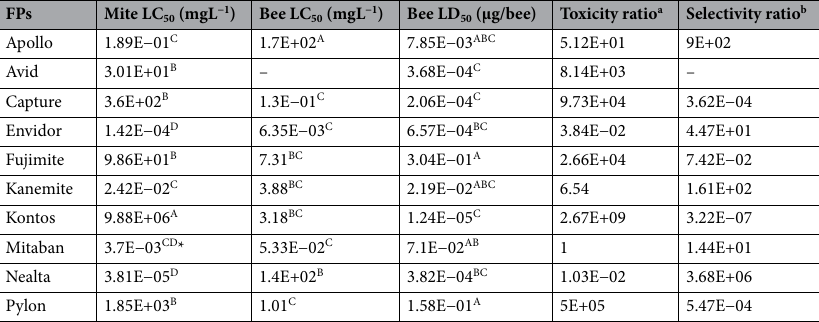
Table 3. Lethal concentration fifty (LC 50 ) and dose fifty (LD 50 ) values for 24 h responses of V. destructor and A. mellifera to tested FPs (n = 10). Mitaban was evaluated as reference control. Values with overlapping CIs in each column are not considered significantly different as indicated with the same letter ( p > 0.05). a Toxicity ratio was calculated by dividing the LC 50 for each AI by LC 50 for Mitaban. b Selectivity ratio was calculated by dividing the LC 50 for honey bee by LC 50 for Varroa mite. *The mite LC 50 value for Mitaban was determined using serial dilutions of 0.0001–100 mgL −1